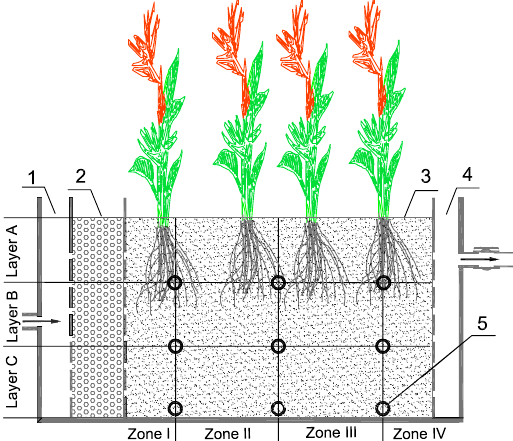
Figure 6. Longitudinal diagram of the horizontal subsurface flow constructed wetlands (HSCWs). (1) Inlet chamber; (2) distribution chamber; (3) growth chamber; (4) outlet chamber; (5) water sampling port. Arrows demonstrate the flow